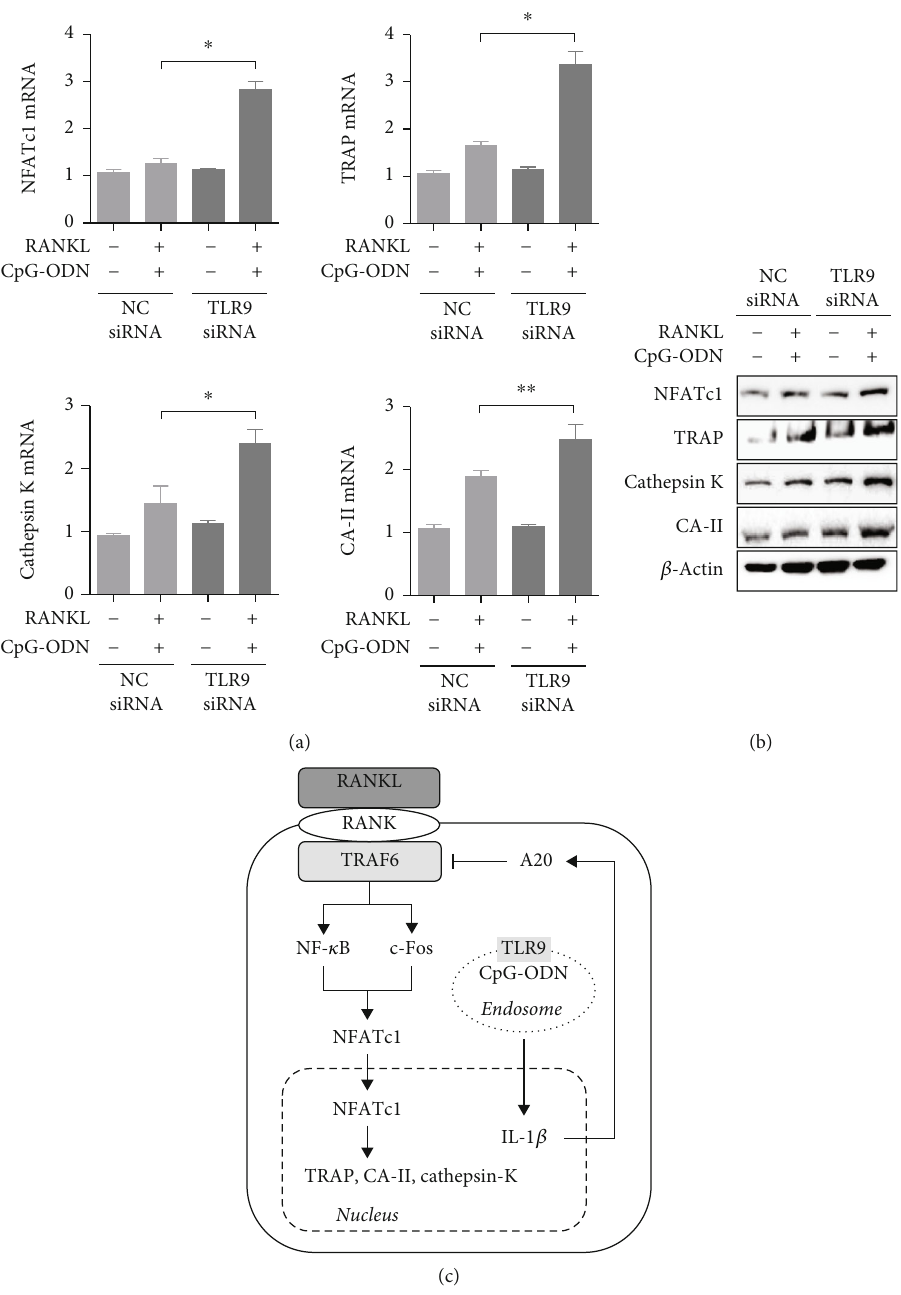
Figure 5: Inhibitory e ff ect of CpG-ODN on RANKL-induced osteoclast formation via TLR9. (a, b) mRNA and protein expressions of osteoclast-speci fi c molecules such as NFATc1, TRAP, cathepsin K, and CA-II were measured in TLR9 siRNA transfected RAW 264.7 cells incubated with both RANKL and CpG-ODN. (c) RANKL-TRAF6-dependent signal pathway initiates di ff erentiation and formation of multinucleated osteoclasts through activation of osteoclast-speci fi c molecules, together with maturation of interleukin-1b. CpG-ODN ampli fi es IL-1 β expression, in turn leading to A20 expression. Finally, CpG-ODN-IL-1 β -A20-TRAF6 signal transduction plays a negative role in RANKL-induced osteoclast formation. Abbreviation: NC: negative control; NFATc1: nuclear factor of activated T cells c1; TRAP: tartrate-resistant acid phosphatase; CA-II: carbonic anhydrase-II. Error bars represent standard deviation of the measurement of three separate samples ( ∗ p < 0 : 01 and ∗∗ p < 0 : 05